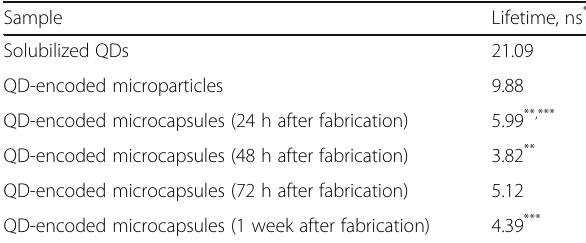
Table 2 Quantum dot fluorescence lifetime data